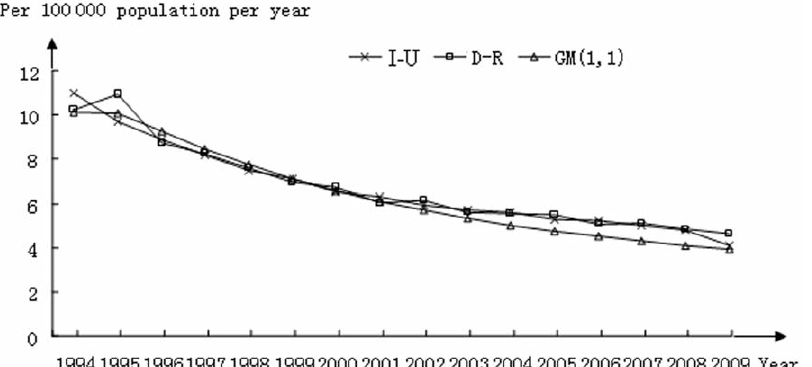
Figure 1. Incidence of tuberculosis in the US; a comparison between actual (I-U) and calculated datasets using the D-R and GM(1,1)